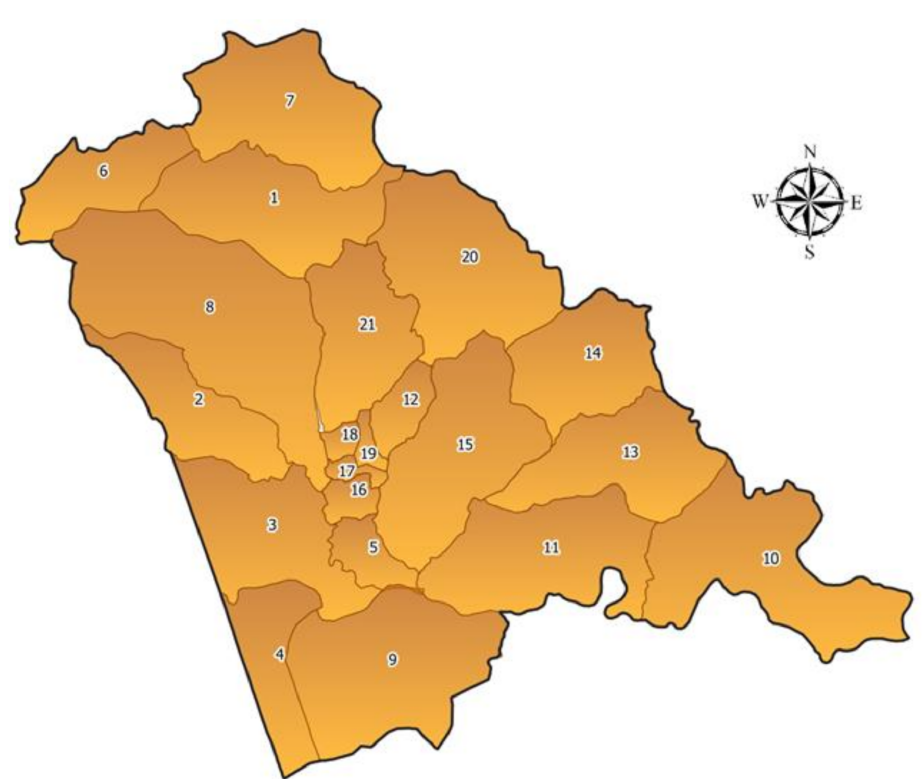
Figure 2. Sussundenga village map and Bairro’s. 1. Nhamatiquite, 2. Samora Machel, 3. Bapua, 4. Congrosso, 5. Chizizira, 6. 3 de Fevereiro, 7. Mussacumbira, 8. Nhamarenza, 9. Dhoa, 10. Chissamba, 11. Nhaguzue, 12. Chissanba, 13. Chipendeque, 14. Tave, 15. Muzoria, 16. Unidade, 17. 7 de Abril, 18. 25 de Junho 2, 19. 25 de Junho 1, 20. Nhamawaia, e 21.